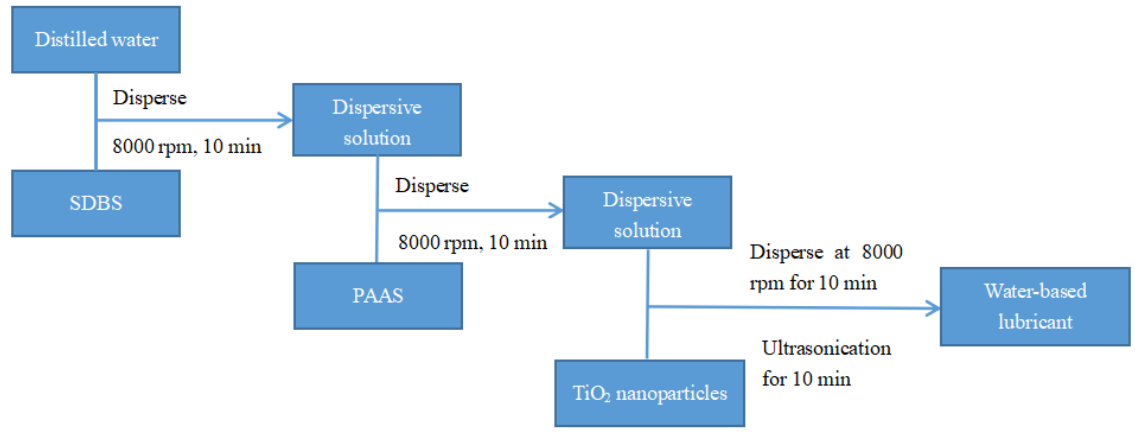
Figure 1. The chart of preparation of TiO 2 nano-additive water-based lubricants.